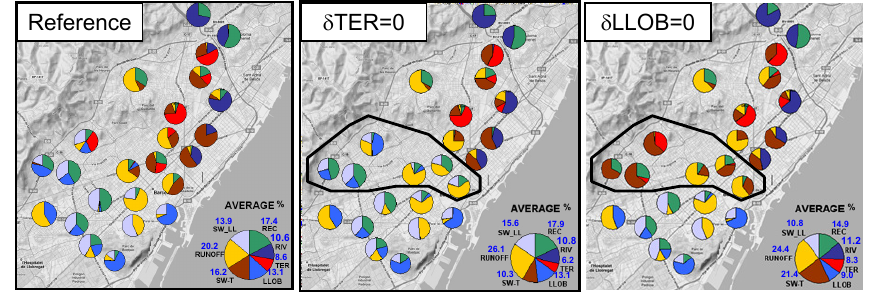
Fig. 4. Sensitivity of mixing results in the case of linear combination for all species in some end-member waters. All computations are performed with 12 species, 24 wells and 8 recharge sources. Results display the mixing ratios computed by (1) center: fixing the mixing ratios of TER and SW TER to zero at the wells located in this area, (2) right: fixing LLOB and SW LLOB to zero, and (3) left: not fixing them.